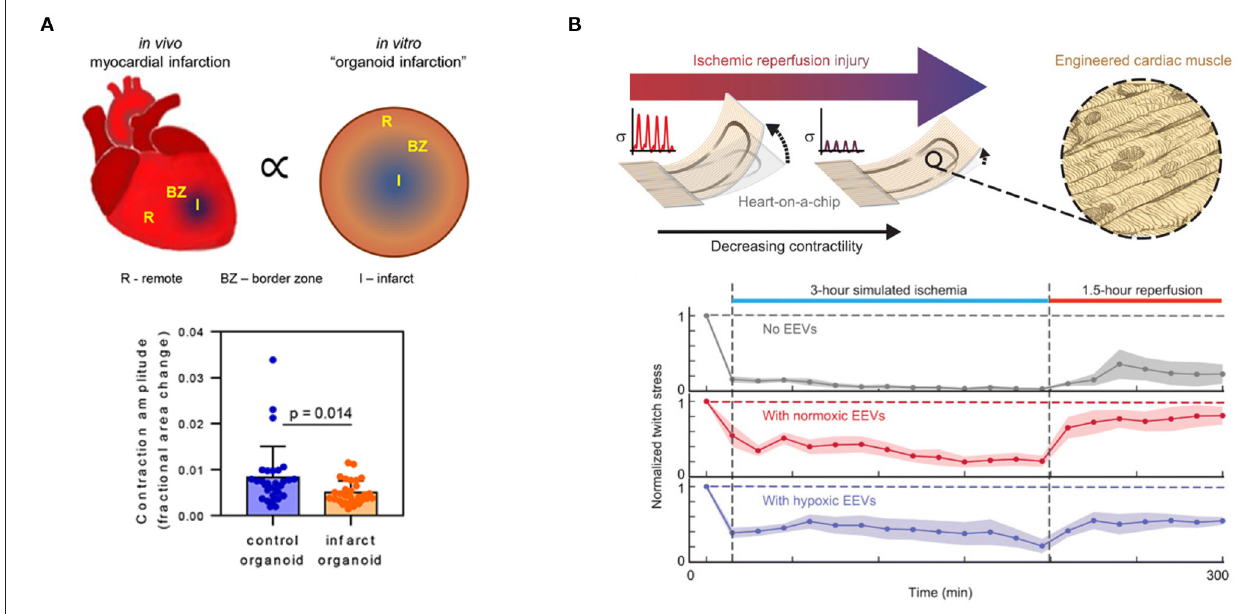
FIGURE 2 | Engineered in vitro hypoxia models that modulate oxygen in (A) space and (B) time. (A) Infarct spheroids generate intrinsic spatial oxygen gradients to model the infarct, border, and remote zones after myocardial infarction. Infarct spheroids exhibit higher levels of myofibroblast marker expression, exhibit asynchronous contraction of myocytes, and have lower contraction amplitudes than control spheroids. Reprinted by permission from Springer Nature: Nat. Biomed. Eng. (78). (B) Muscular thin films with integrated strain gauges can measure changes in contractility in cardiac myocytes pre-treated with endothelial extracellular vesicles in a simulated ischemia-reperfusion injury. Endothelial extracellular vesicles enhanced the contractility of engineered cardiac tissues during both ischemia and reperfusion. From Yadid et al. ( 79). Reprinted with permission from